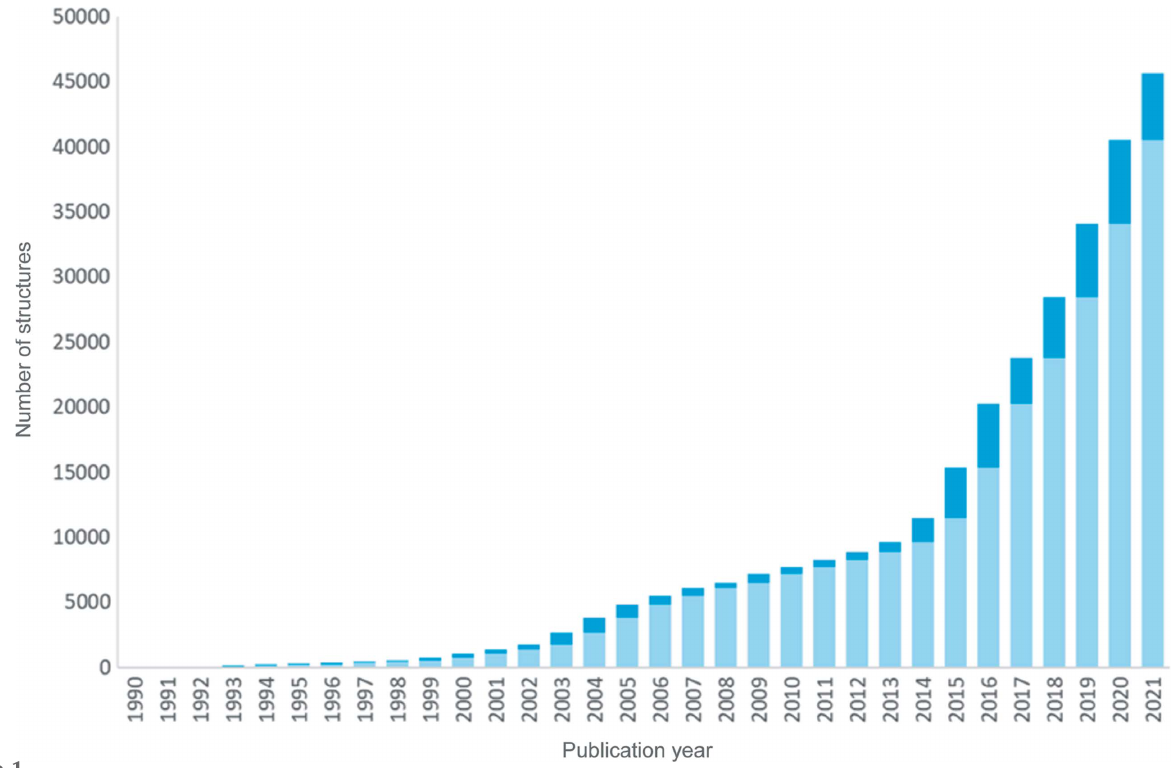
Figure 1 Chart showing the growth in the number of CSD Communications . The stacked bars represent the number of structures added that year in dark blue and the cumulative number of structures from previous years in light